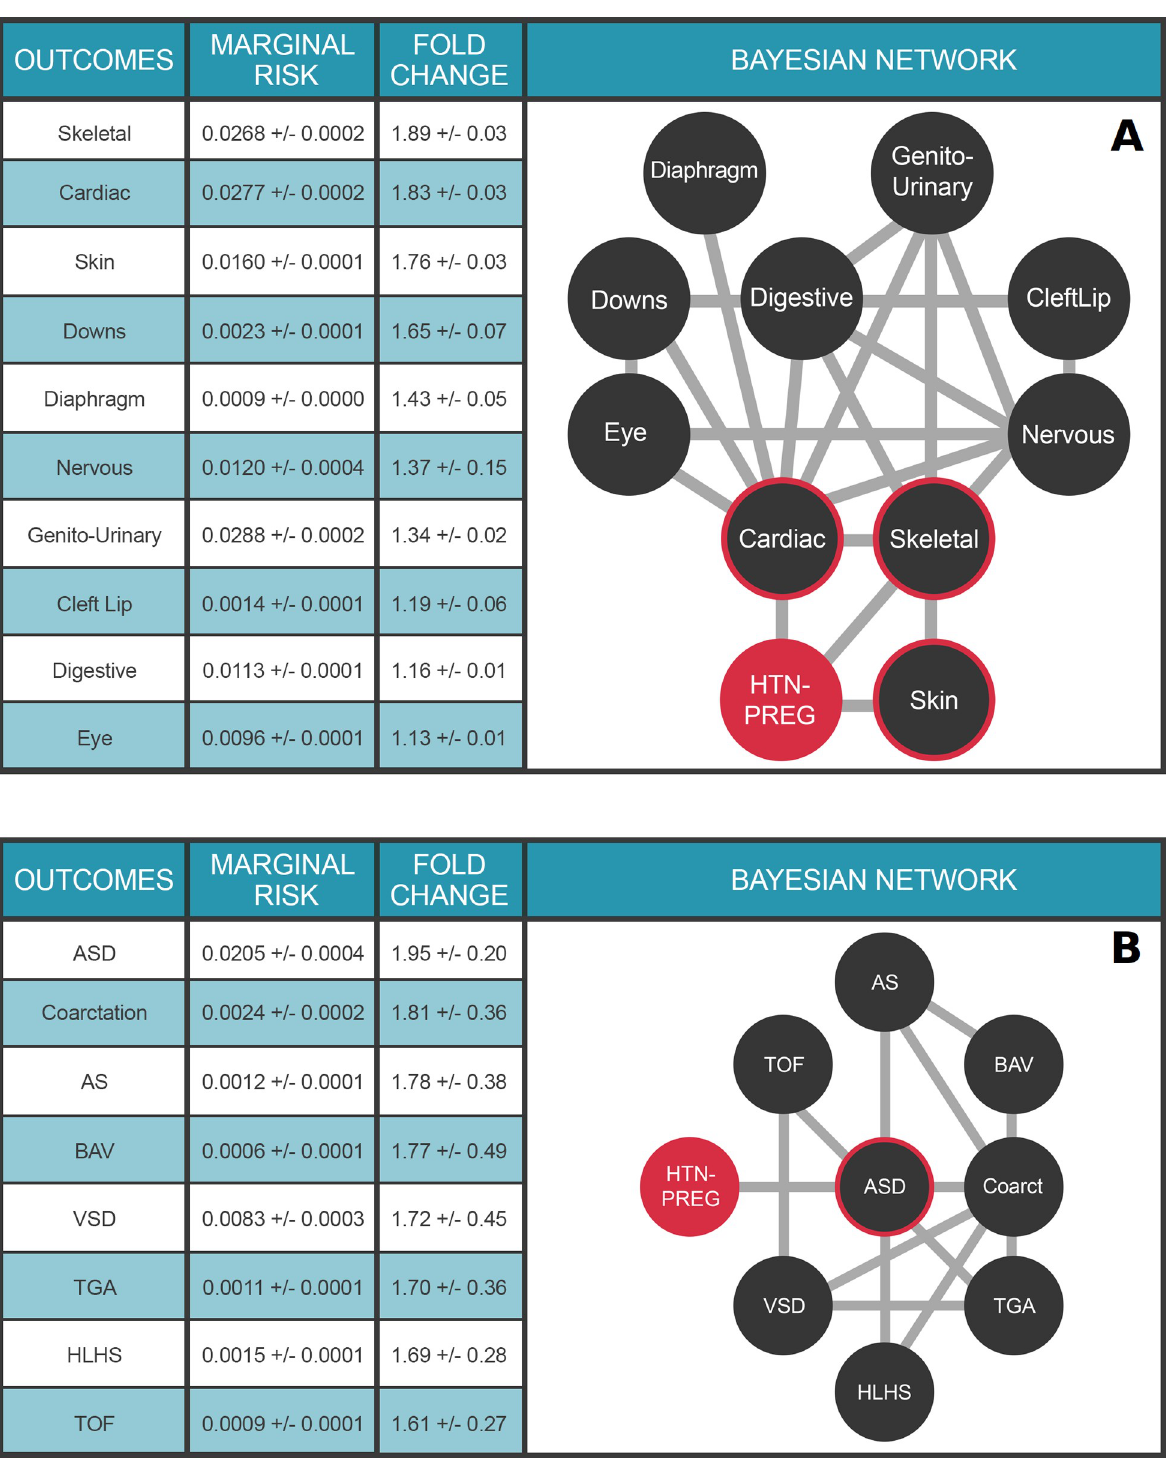
Fig 5. Impact of maternal health on congenital anomalies in the child. Panel A. Multimorbidity landscape for child’s risk for congenital malformations in the context of pregnancy-induced hypertension. N = 125,014 mothers. Clinical variable terms represent CCS billing codes present in the EHR database. Maternal diagnosis is highlighted in orange; HTN-Preg: Maternal diagnosis of hypertension complicating pregnancy (aka, pregnancy-induced hypertension); Diaphragm: Diaphragmatic congenital abnormalities; Genito-Urinary: Genito-Urinary congenital abnormalities; Cardiac: Cardiac and Circulatory congenital abnormalities; Skeletal: Skeletal congenital abnormalities; Down: Trisomy 21; Digestive: